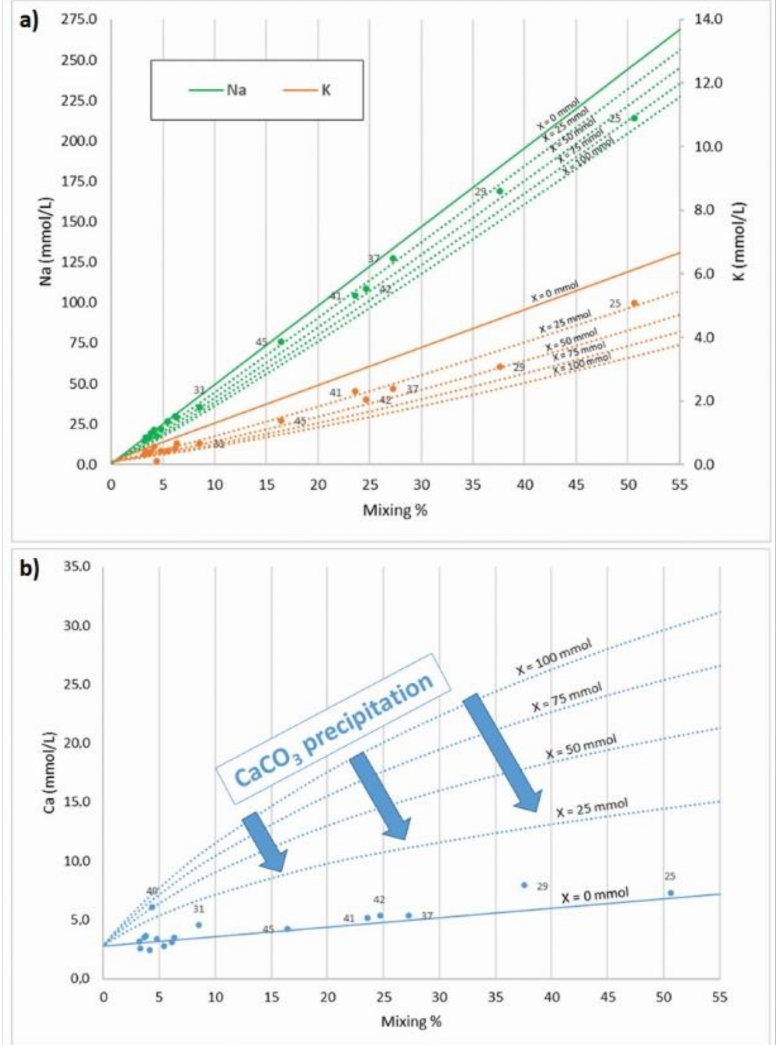
Figure 6. Comparison between pure mixing (continuous line) and simulated concentrations obtained coupling the model mixing + ion exchange (dotted lines) at different exchanger concentrations. ( a ) Na and K (left and right ordinate scale, respectively); ( b )